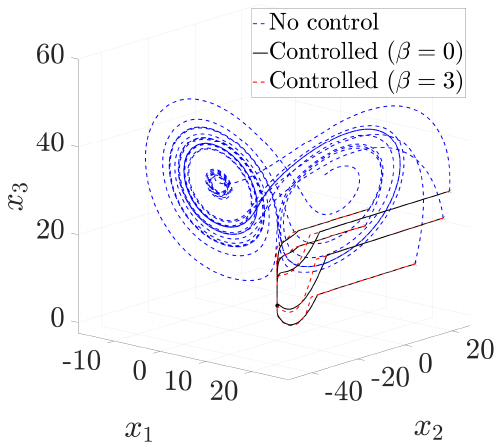
Figure 3. Lorenz dynamics stabilized by proposed